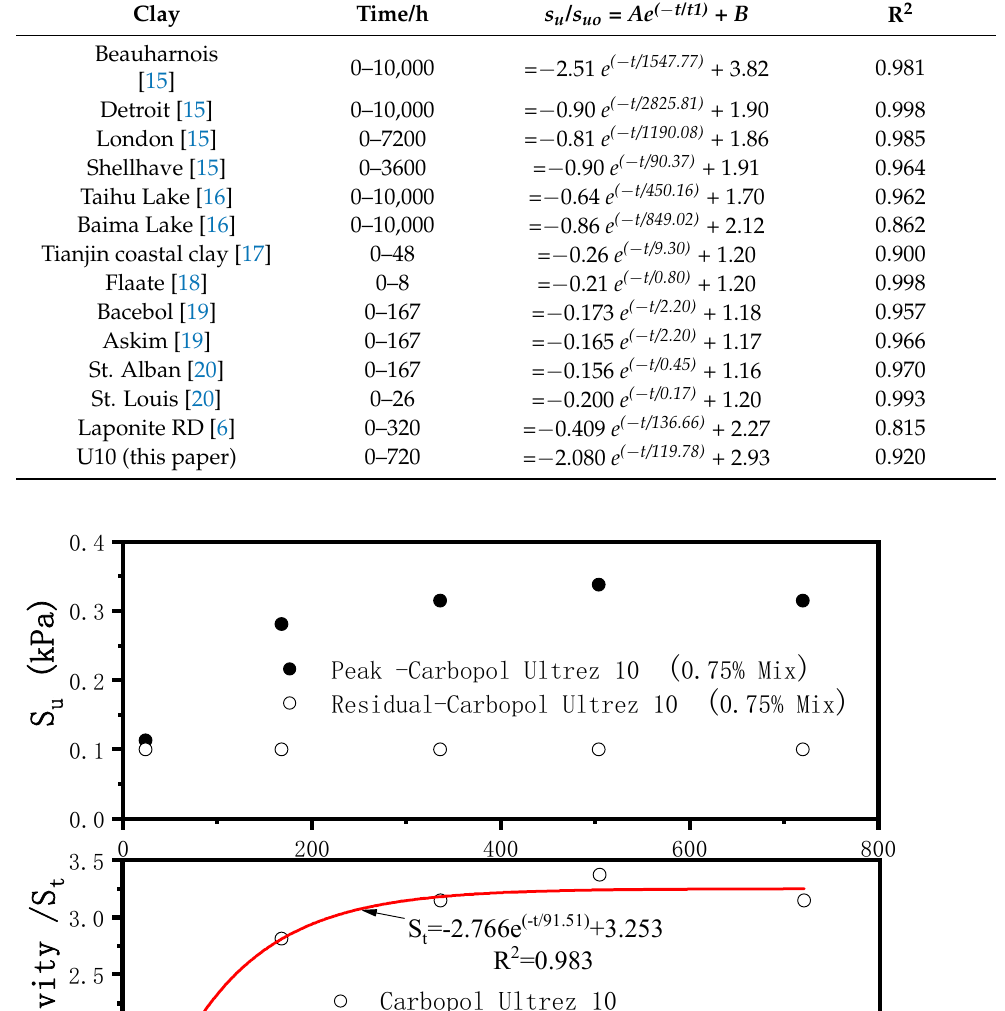
Table 1. Summary of relationships between thixotropic ratio and time.